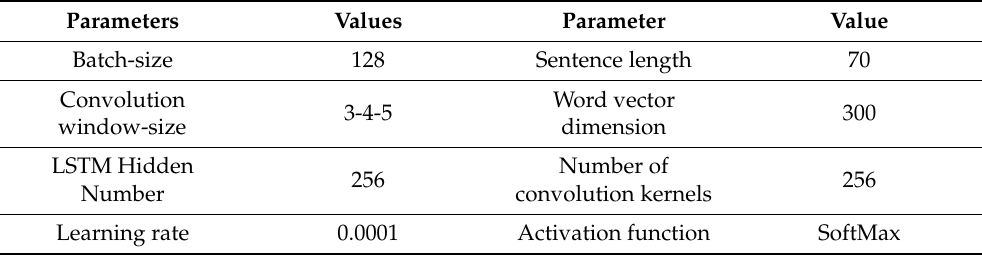
Table 7. Experimental Parameter